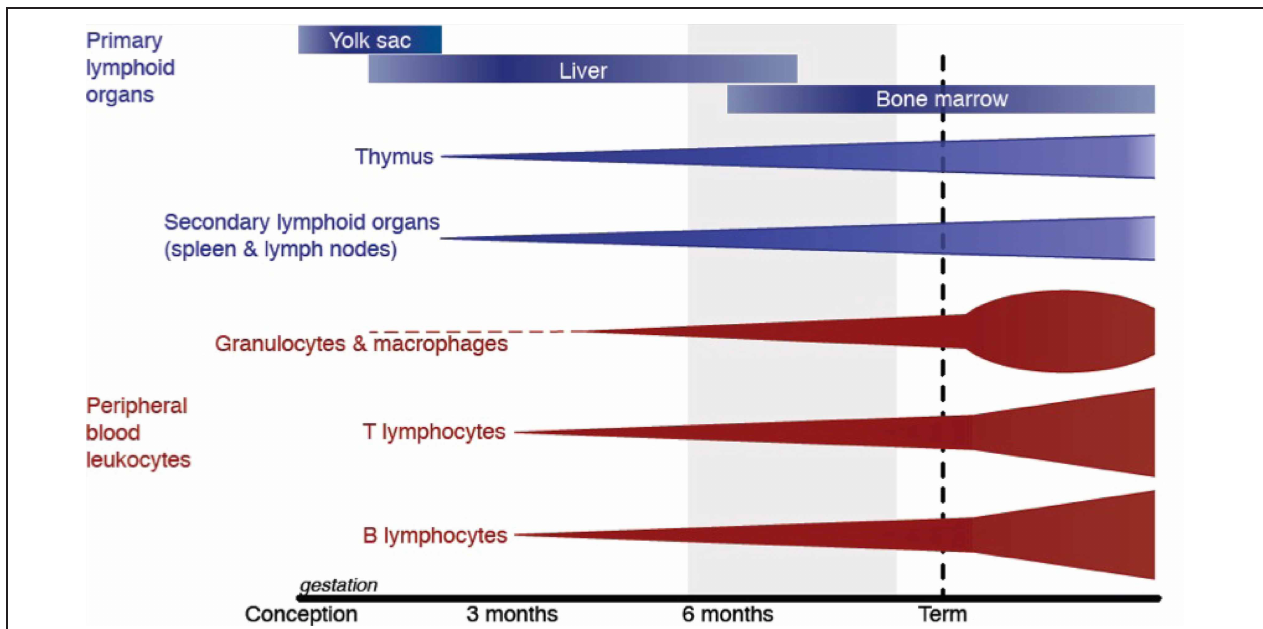
FIGURE 1 | Leukocyte development begins in the yolk sac before moving to the liver and finally the bone marrow. The development and maturation of primary lymphoid organs (blue) and peripheral blood leukocytes (red) occur throughout gestation but is not complete until